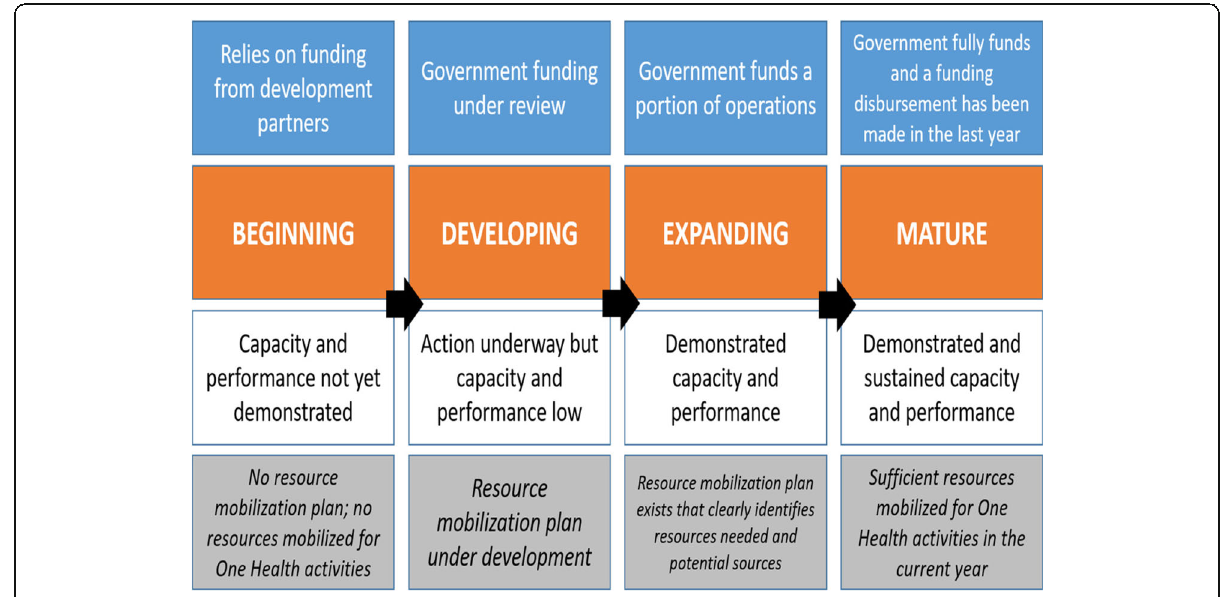
Fig. 2 The National One Health Platform maturity model for capacity and